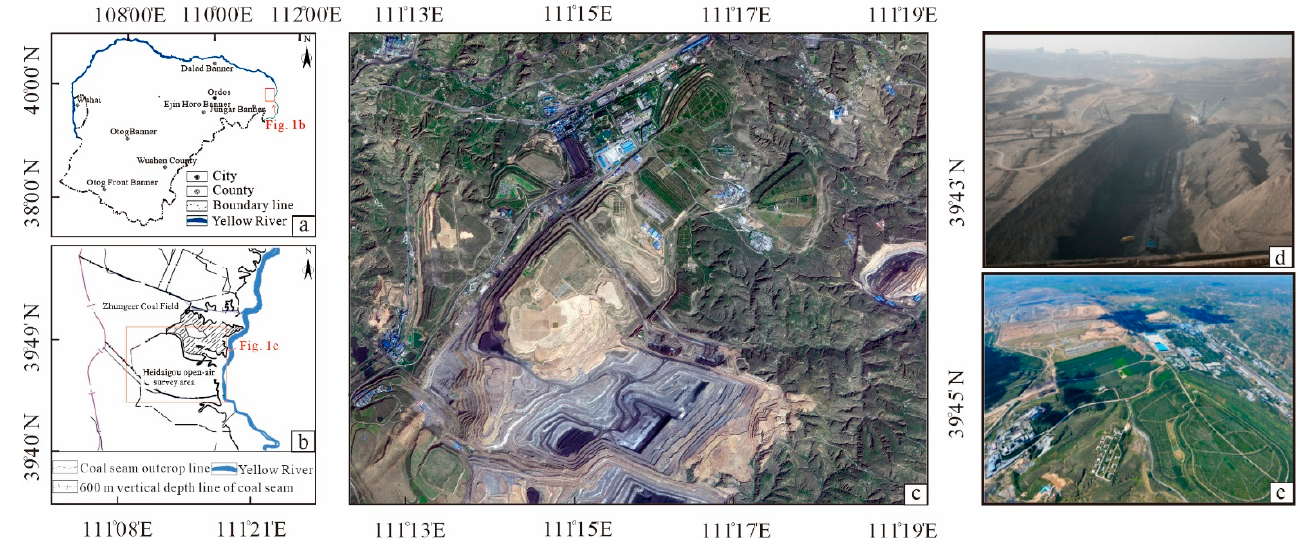
Figure 1. ( a ) The geographic location of the Jungar coalfield. ( b ) The geographical location of the Heidaigou mine area. ( c ) A remote sensing image map of the mine area in 2021. ( d ) A photograph of the mining site in Heidaigou. ( e ) The present situation of the slope greening of the waste dump in the Heidaigou mine.